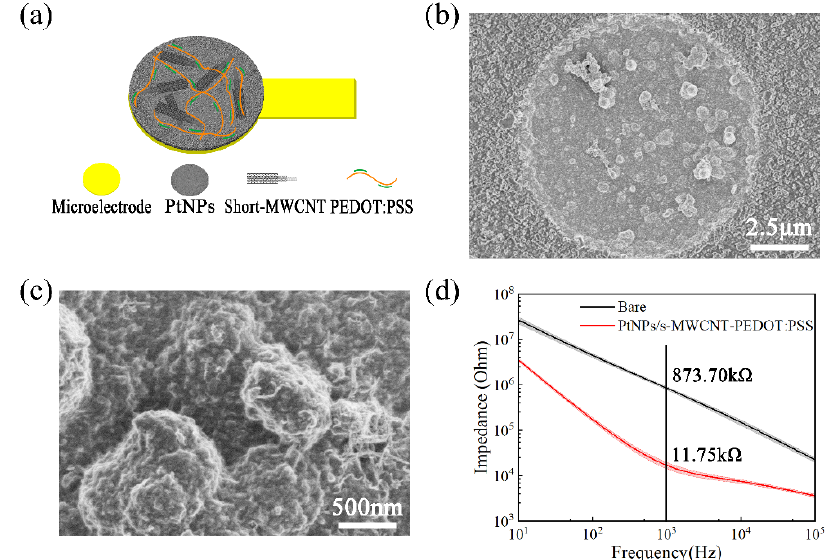
Figure 3. Morphology and impedance characteristics of the MEA sites. ( a ) MEA site modification protocol; ( b ) Scanning electron microscopy images (magnification: 5 k) of the PtNPs/short MWCNT- PEDOT: PSS-modified MEA sites; ( c ) Scanning electron microscopy images (magnification: 30 k)